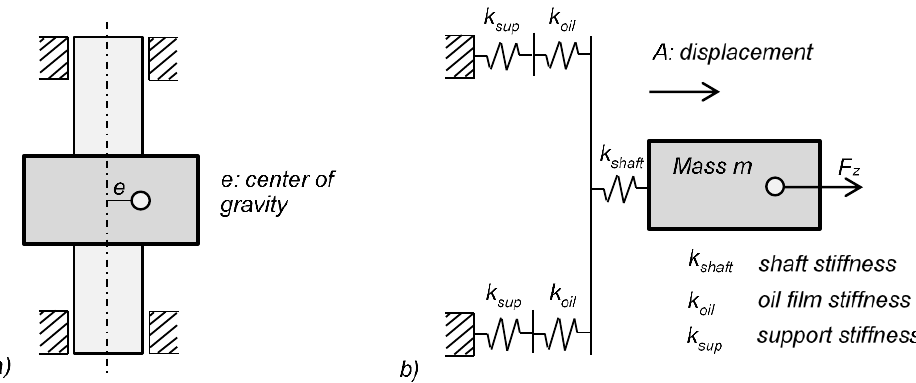
Figure 7. ( a ) Sketch of a simple vertical rotor and ( b ) its analogous model.